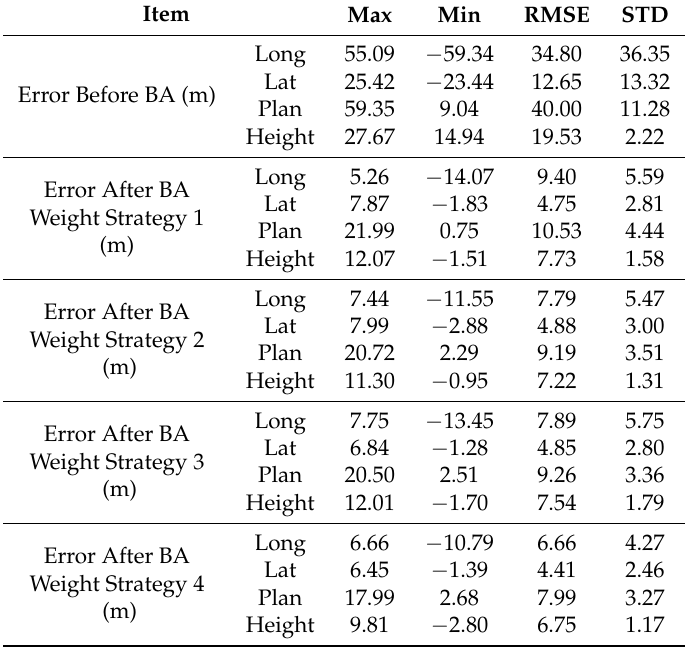
Table 2. Comparison of positioning accuracy with different weight strategies. (BA is the abbreviation of free block adjustment. RMSE represents the root mean square error, STD represents the standard deviation, MAX and MIN are the abbreviation of maximum and minimum, and Lat and Long is the abbreviation of latitude and